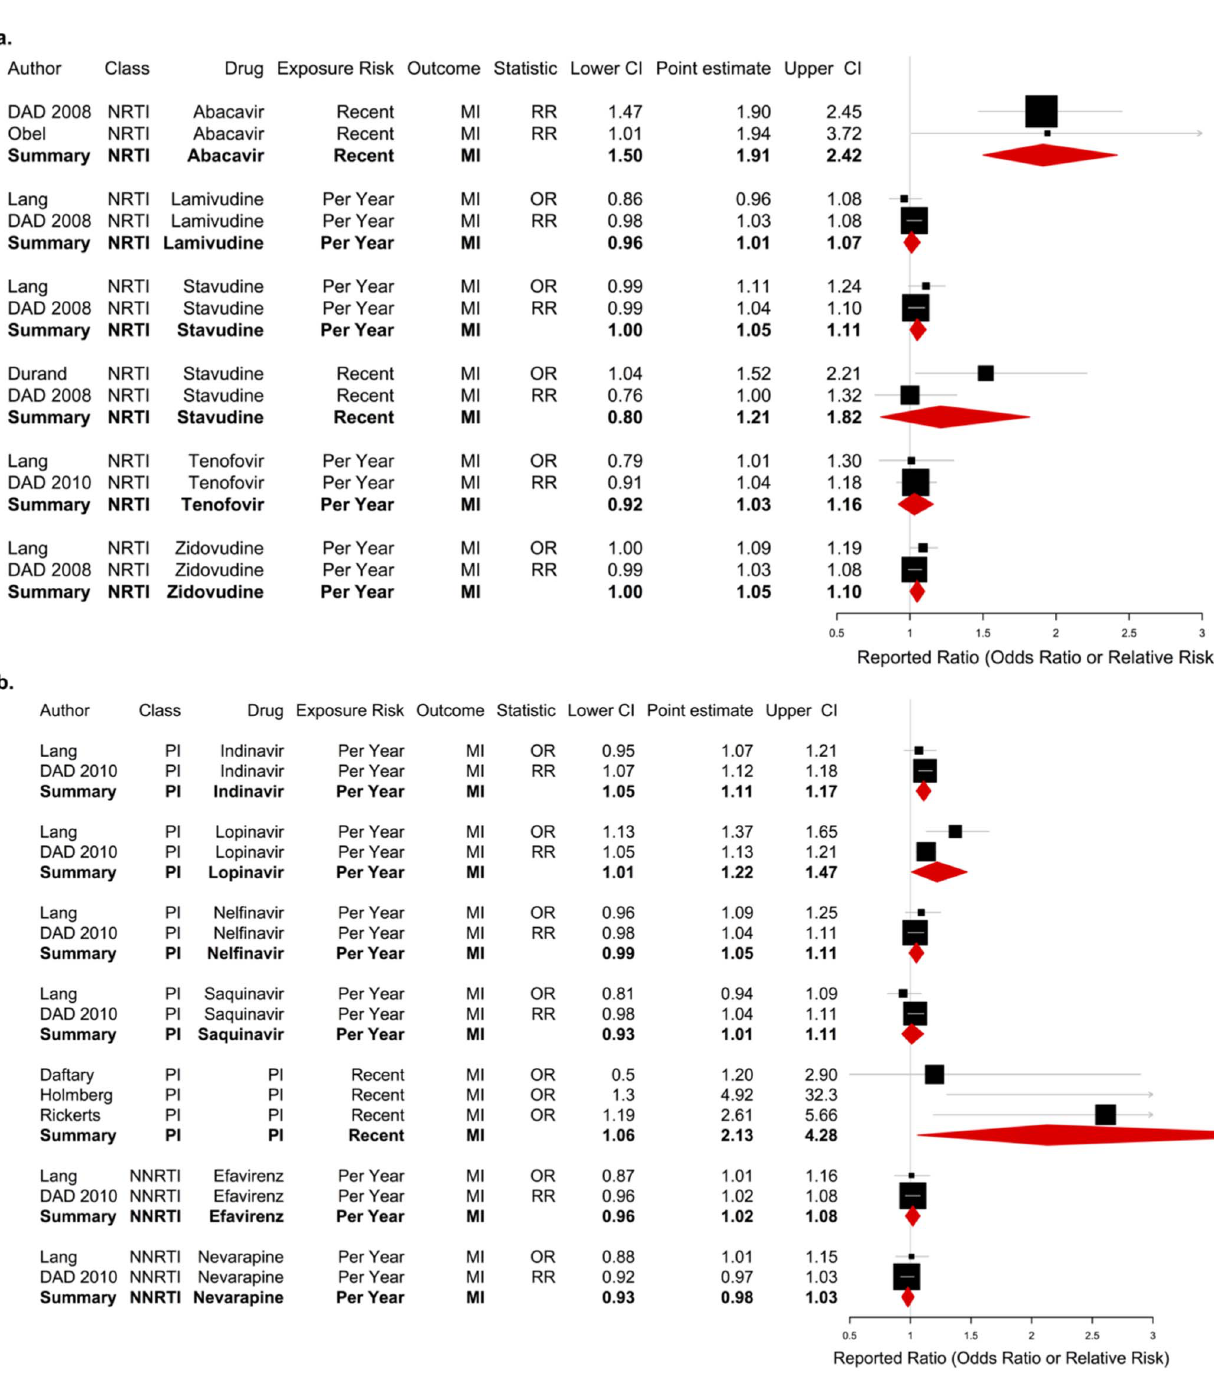
the observational studies include much longer follow up and a more representative sample, but they are subject to confounding by indication, in which risk of cardiovascular disease may influence both ART choice and MI, which may lead to spurious